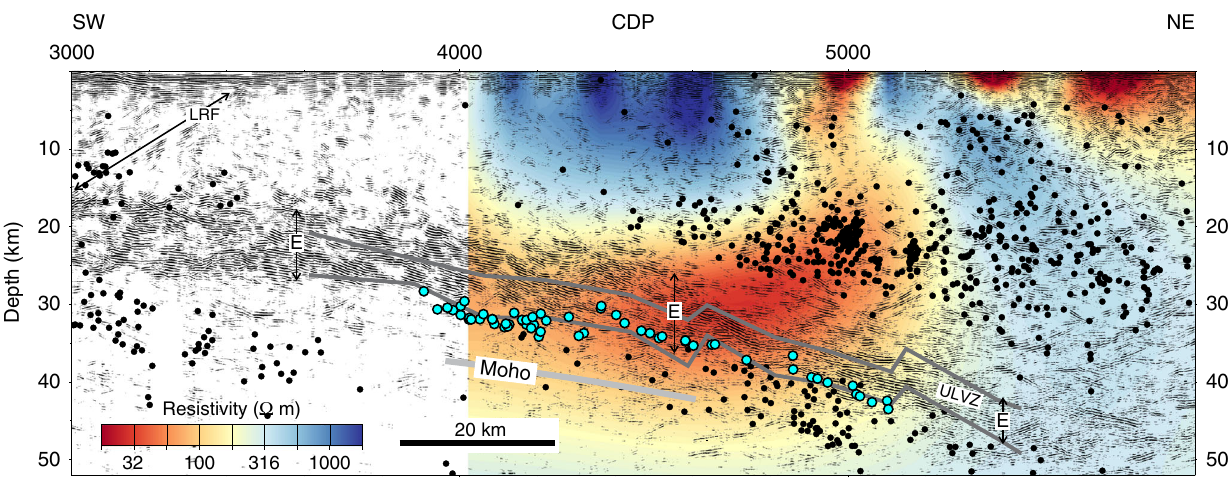
Fig. 4 Composite migrated seismic re fl ection pro fi le offshore Vancouver Island with superimposed resistivity model. Original seismic pro fi les are shown by the brown line in Fig. 1, but the distance along the pro fi le is incremented evenly along an azimuth of 60°. Low-frequency earthquakes ( fi lled blue circles) occur at the base of the landward dipping E re fl ectors, which are interpreted to be a 6 – 10 km thick shear zone, because they truncate overlying faults. A landward dipping zone of relatively low resistivity (30 – 80 Ω m), which has been projected onto the seismic re fl ection pro fi le from the inverted 2D section, corresponds approximately to the E re fl ectors. Filled black circles — earthquakes relocated during 3D tomographic inversion; solid dark grey lines — top and bottom of ultra-low S wave velocity zone (ULVZ) projected from POLARIS (Portable Observatories for Lithospheric Analysis and Research Investigating Seismicity) pro fi le; solid light grey line — Moho of the oceanic plate where it is constrained by wide-angle P wave re fl ections in a previous 3D tomography study 64 ; LRF — Leech River fault at the northwestern edge of the Crescent terrane. CDP Common Depth Point. There is no vertical exaggeration.